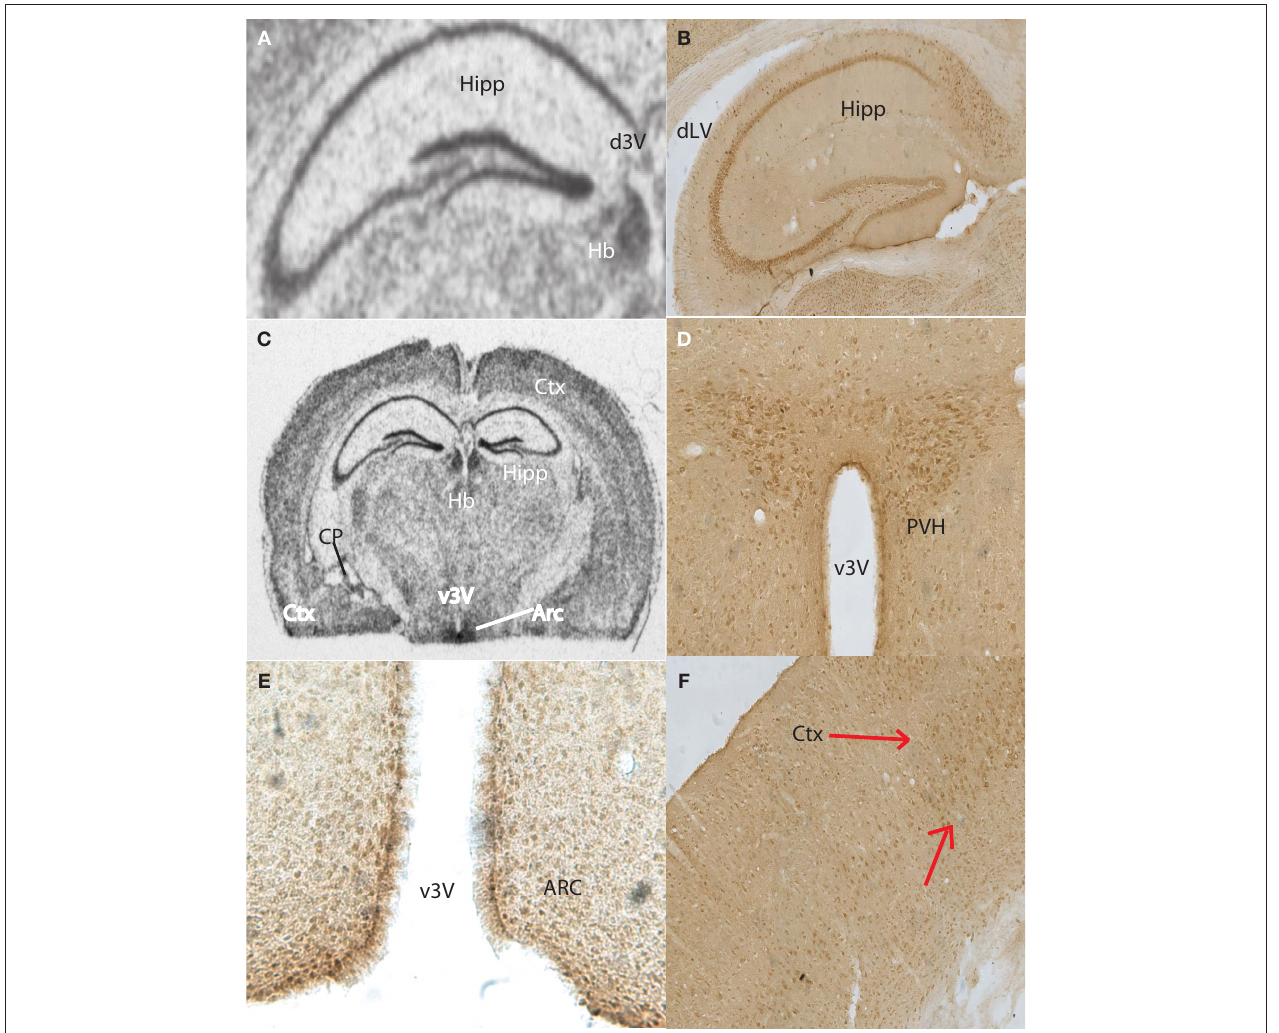
FIGURE 2 | Anatomical distribution of the gene Tas1r2 , and of its product, the taste receptor subunit T1R2. Images from the mouse hippocampus, hypothalamus and cortex obtained from both in situ hybridization and DAB immunolabeling methods were placed alongside. (A) Tas1r2 and (B) T1R2 expression in the hippocampus. Note the strong levels of both gene and protein expression on the CA fi elds and dentate gyrus, further demonstrating the preferential expression of taste-related elements in neurons. Note also the proximity of the hippocampus to the lateral ventricle. (C) Overall view of a brain section hybridized against a Tas1r2 probe. Note the high levels of expression in hippocampus, periventricular, including arcuate nucleus, of the hypothalamus, cortex and habenula. ISH also identifi ed Tas1r2 expression in the epithelial cells